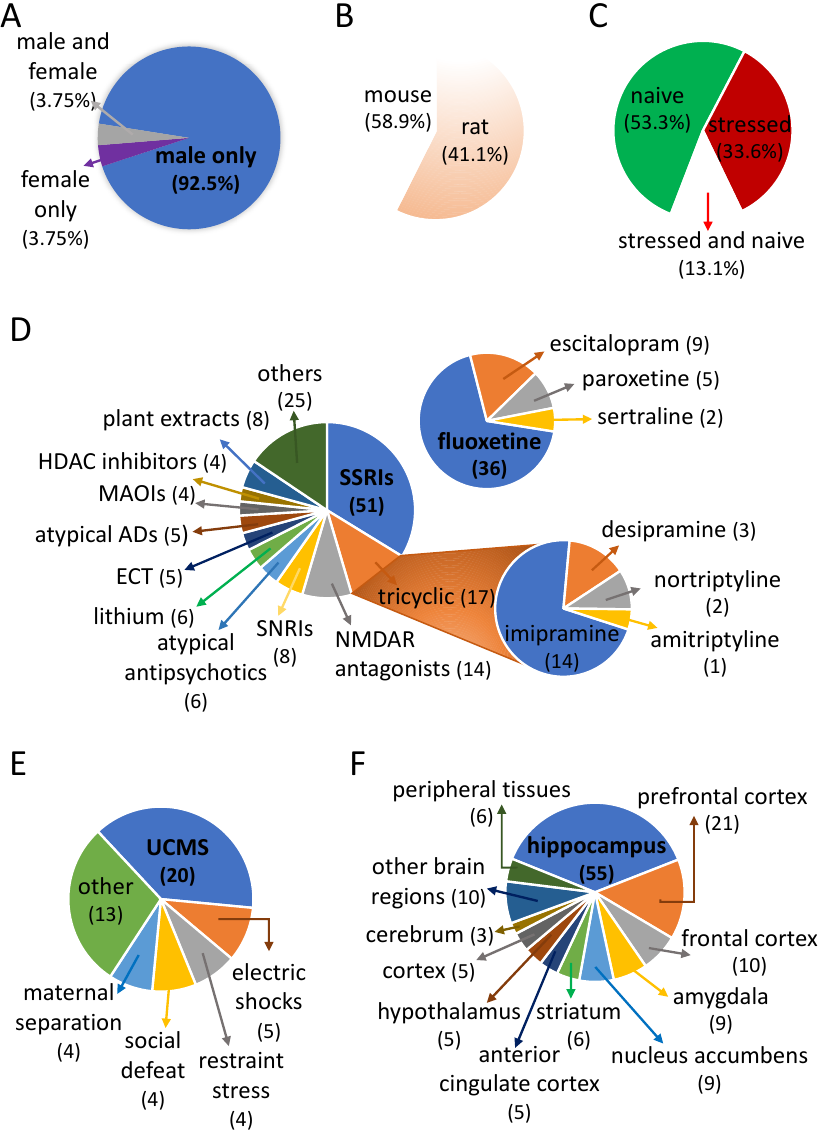
Figure 2. Main features of transcriptomic studies conducted in rodents to investigate the effect of AD treatments. Distribution of the sex ( A ), rodent species ( B ), and use of a stimulation to induce depression-like behaviors before testing the effect of ADs ( C ). ( D ) Diversity of the class of ADs used with detailed proportions for SSRIs and tricyclics. ( E ) Variety of paradigms used to induce depression-like symptoms. ( F ) Anatomical distribution of collected tissues. Numbers in parentheses indicate the number of studies where an AD ( D ), a type of stress ( E ), or a specific piece of tissue ( F ) has been examined.